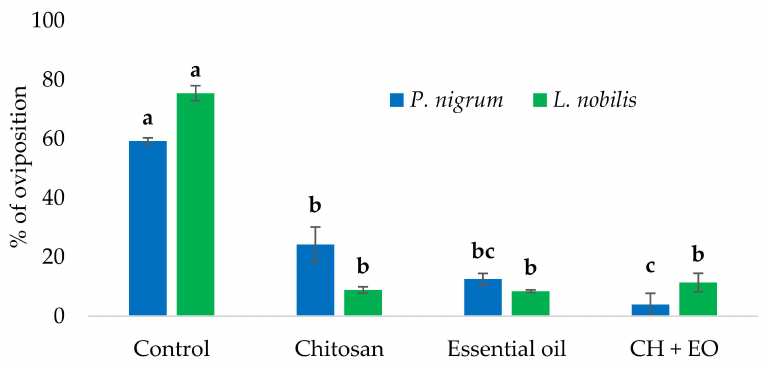
Figure 7. Protective effect of chitosan (CH), the Laurus nobilis and Piper nigrum essential oils (EOs), and EOs-enriched CH solutions against the oviposition of the blowfly Calliphora vomitoria on beef meat. For each EO, different letters (a–c) indicate significant differences among treatments with the same EO (Tukey’s HSD, p ≤ 0.05).